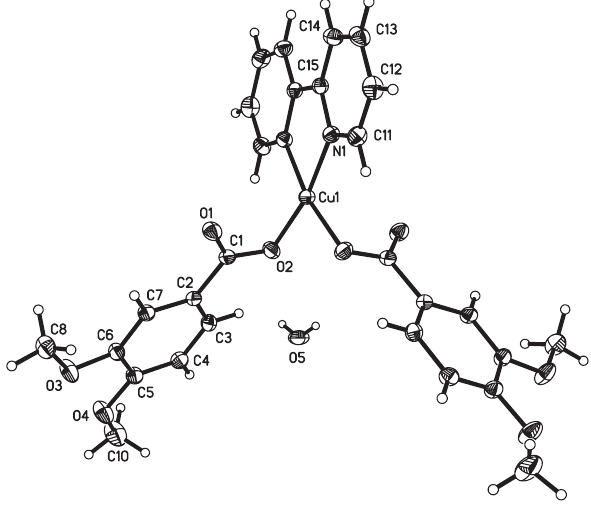
Table 1: Data collection and